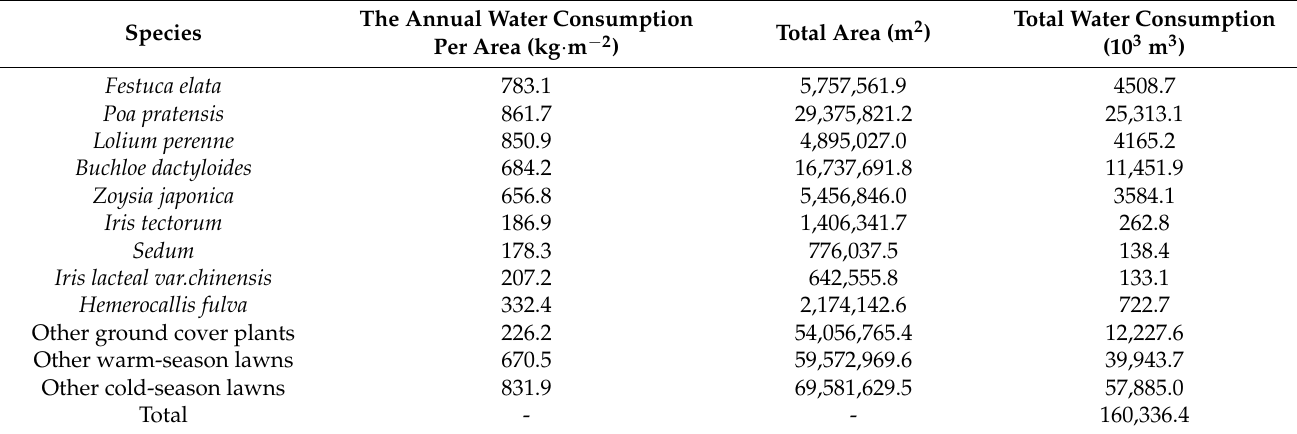
Table 14. Annual water consumption of herbs in Beijing.